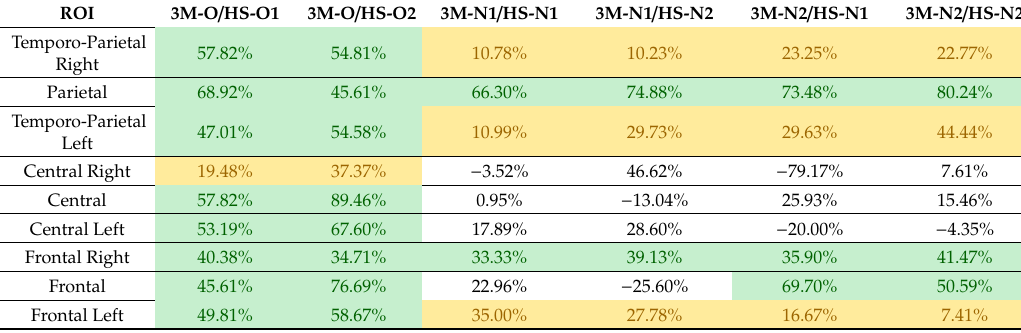
Percentage di ff erence, by ROIs, between the green regions (area of the power spectrum ≤ 4 Hz) in Figure 3 for subjects with 3M syndrome and control subjects. Data that exhibit concordant positive values are highlighted in